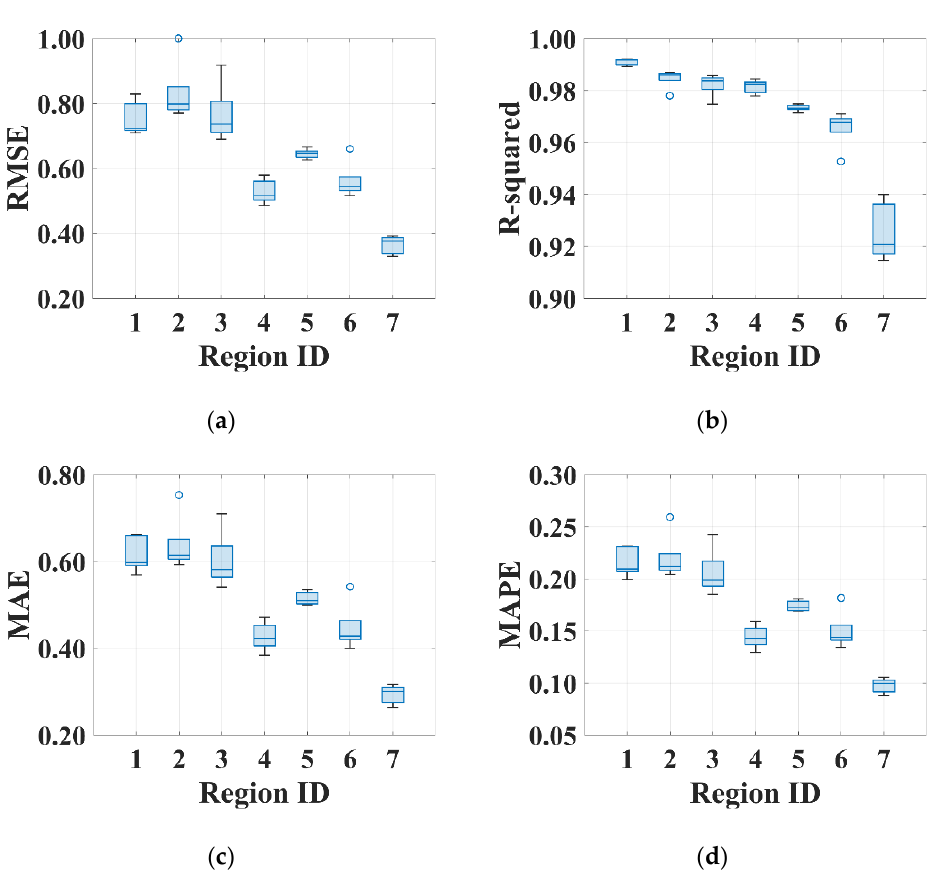
Figure 13. The distribution of the evaluation index for five runs: ( a ) RMSE , ( b ) R-squared, ( c ) MAE and ( d ) MAPE . Table 4. Comparison of R 2 , RMSE , MAE and MAPE for seven study areas (average for five runs). Region ID